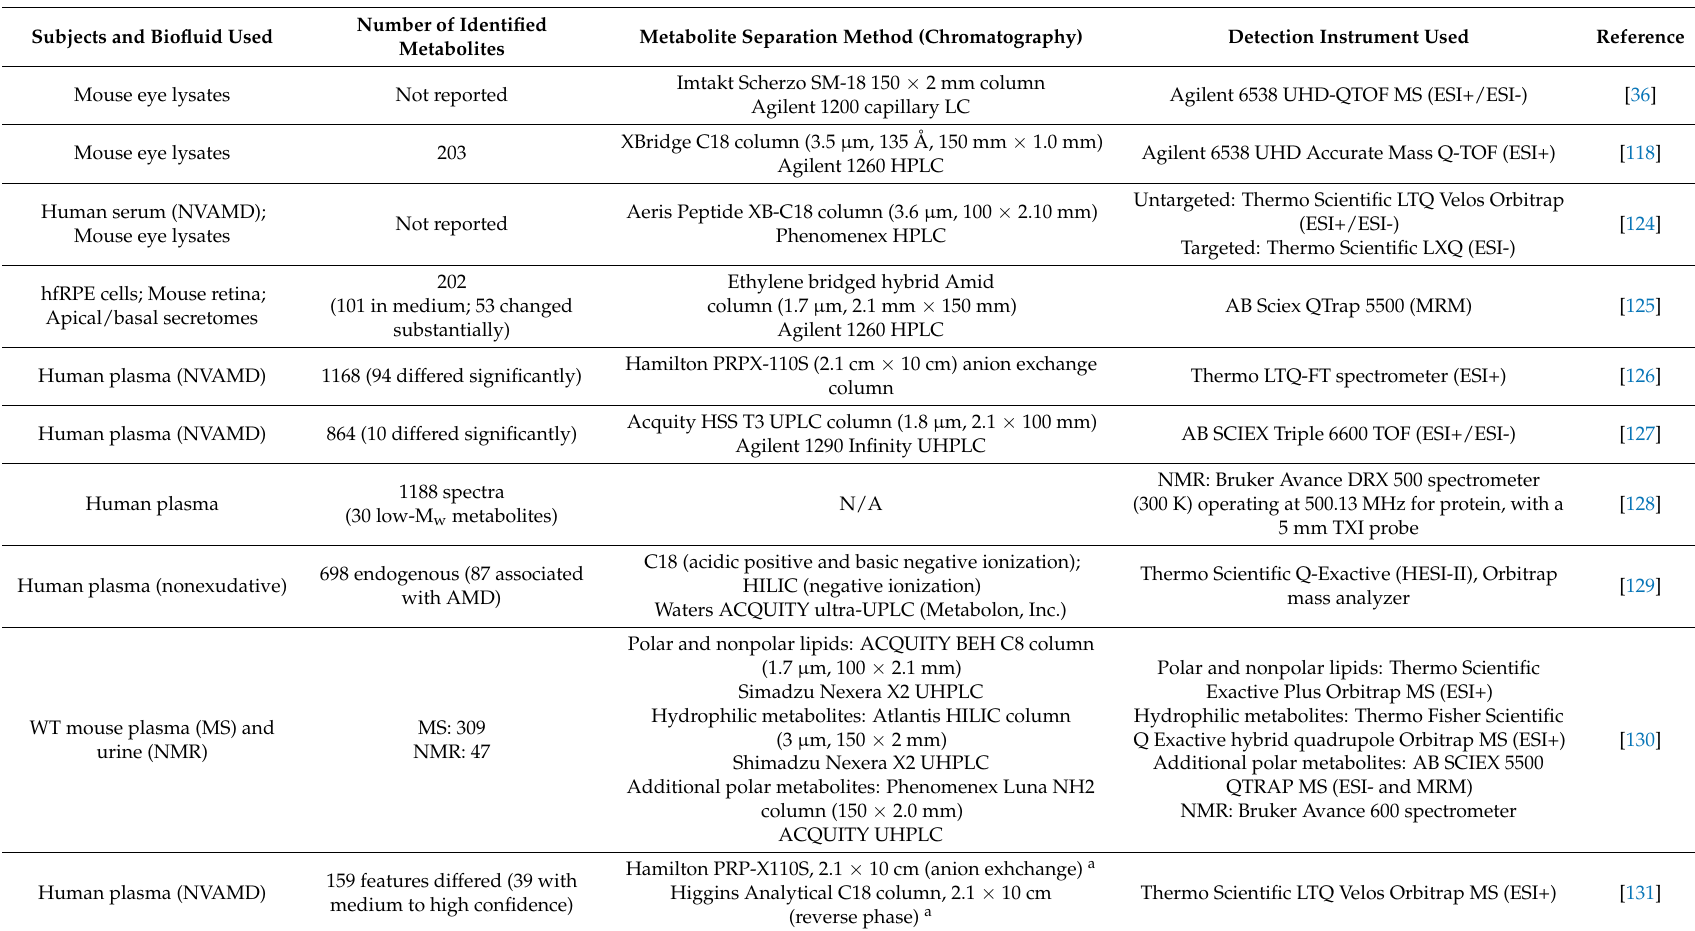
Table 1. Summary of untargeted metabolomic studies investigating AMD, including details of the tissue/biofluid profiled, and methods and instrumentation